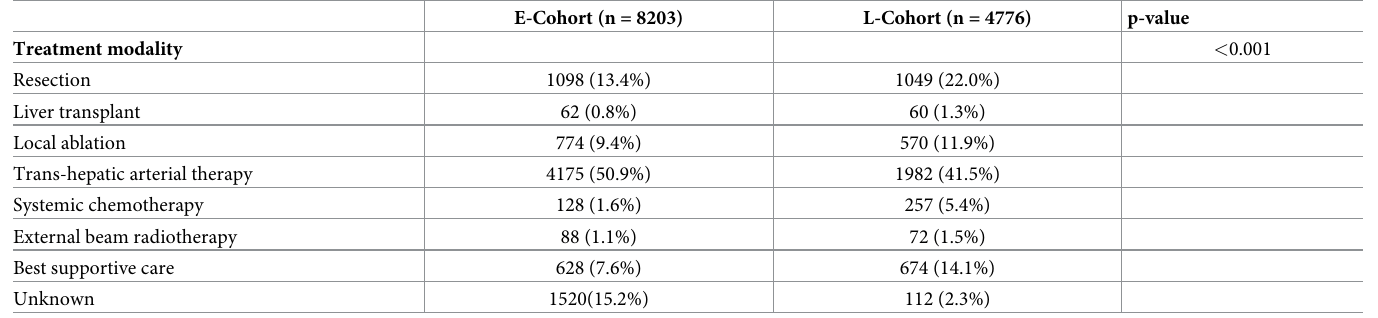
Table 2. The first-line treatment modalities between the E-Cohort and the L-Cohort.